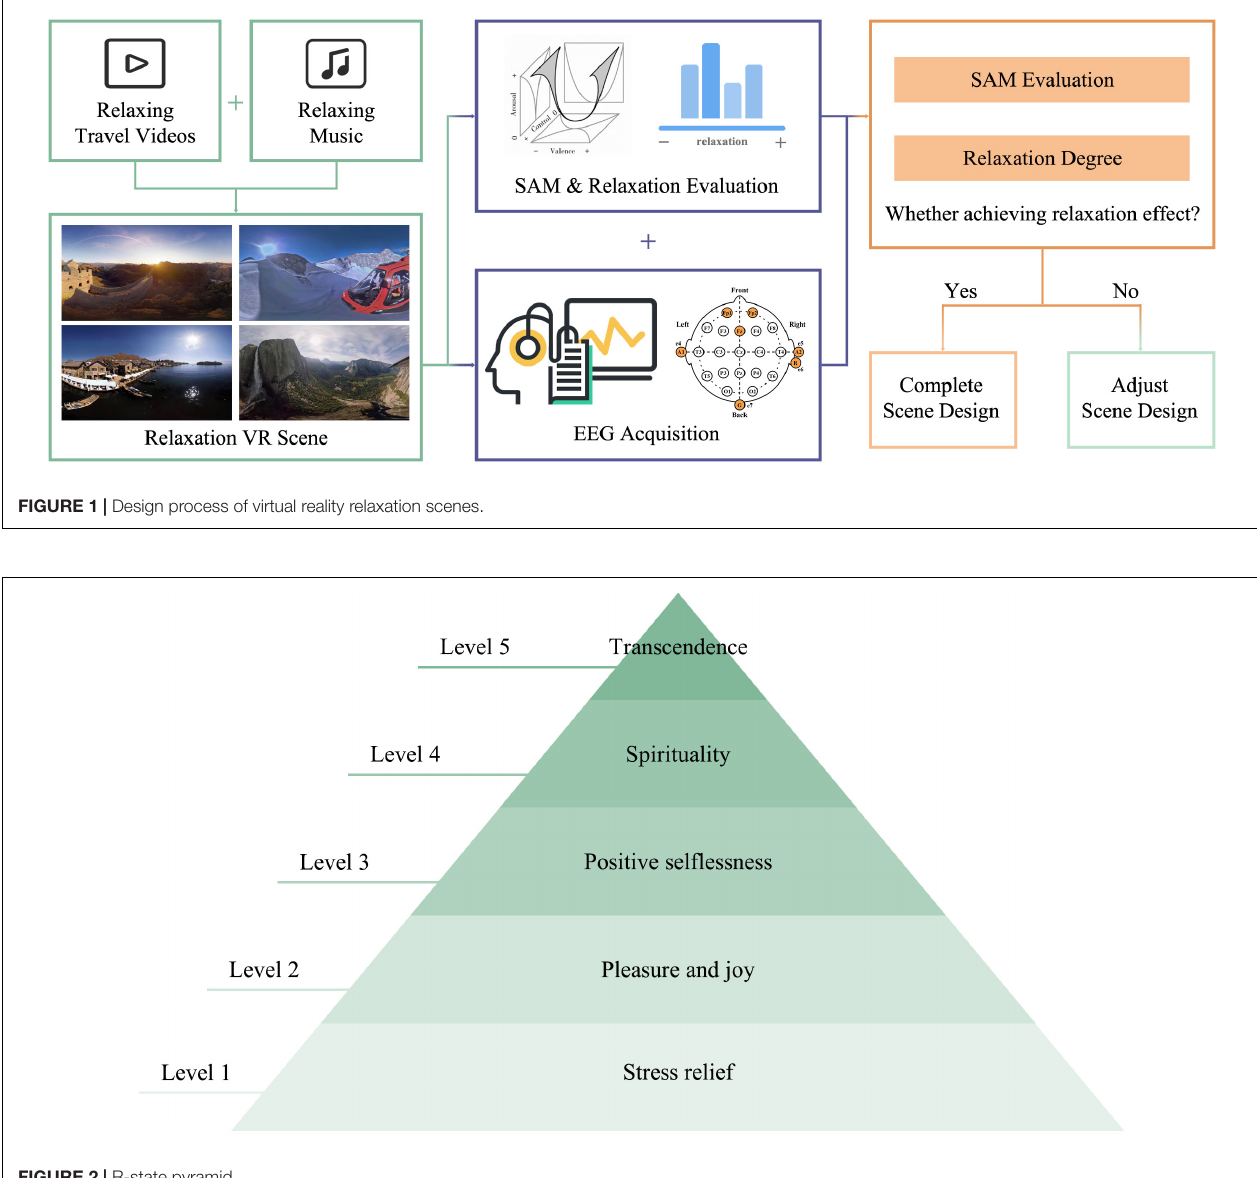
FIGURE 2 | R-state